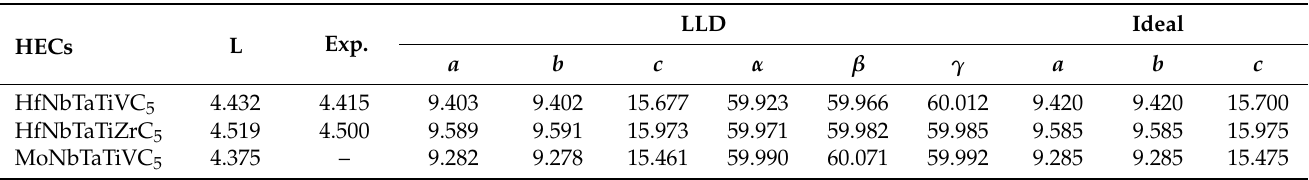
Table 2. The converted lattice parameter L of the equilibrium state (Å), the available experiments, lattice parameters ( a , b , c and α , β , γ ) of the SAE supercell for the high entropy carbides (HECs) with/without distortion. LLD Ideal HECs L Exp. a b c α β γ a b